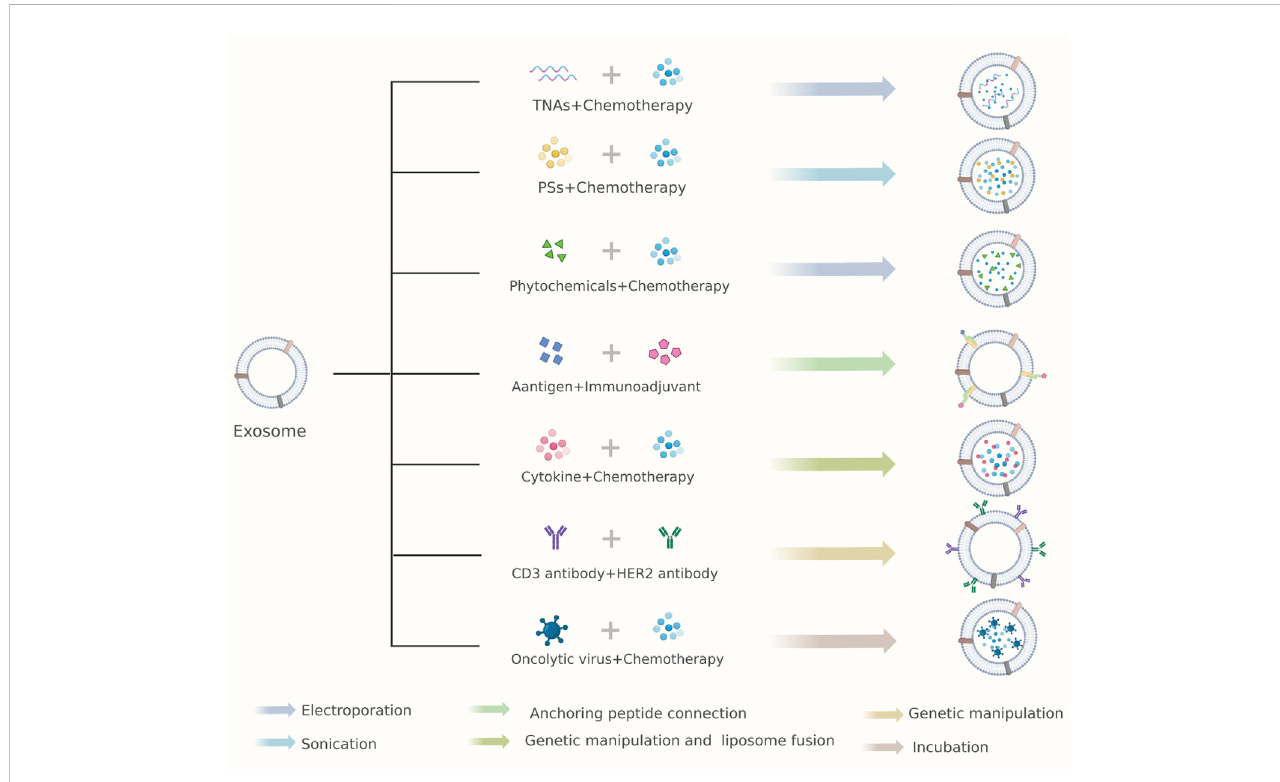
FIGURE 2 Combinational antitumor strategies of exosomes as drug carriers. Arrows with different colors represent various drug loading methods. TNAs, therapeutic nucleic acids; PSs, photosensitizers; Her2, human epidermal growth factor receptor 2.